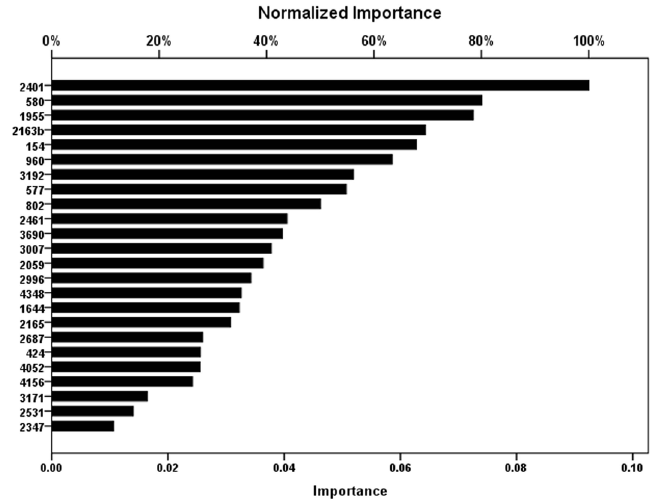
Figure 7. Importance value of independent variables (24 MIRU-VNTR loci) useful for predicting three dominant spoligotypes (Beijing orCAS1_Delhi, orT1) based on artificial neural network (ANN) analysis.